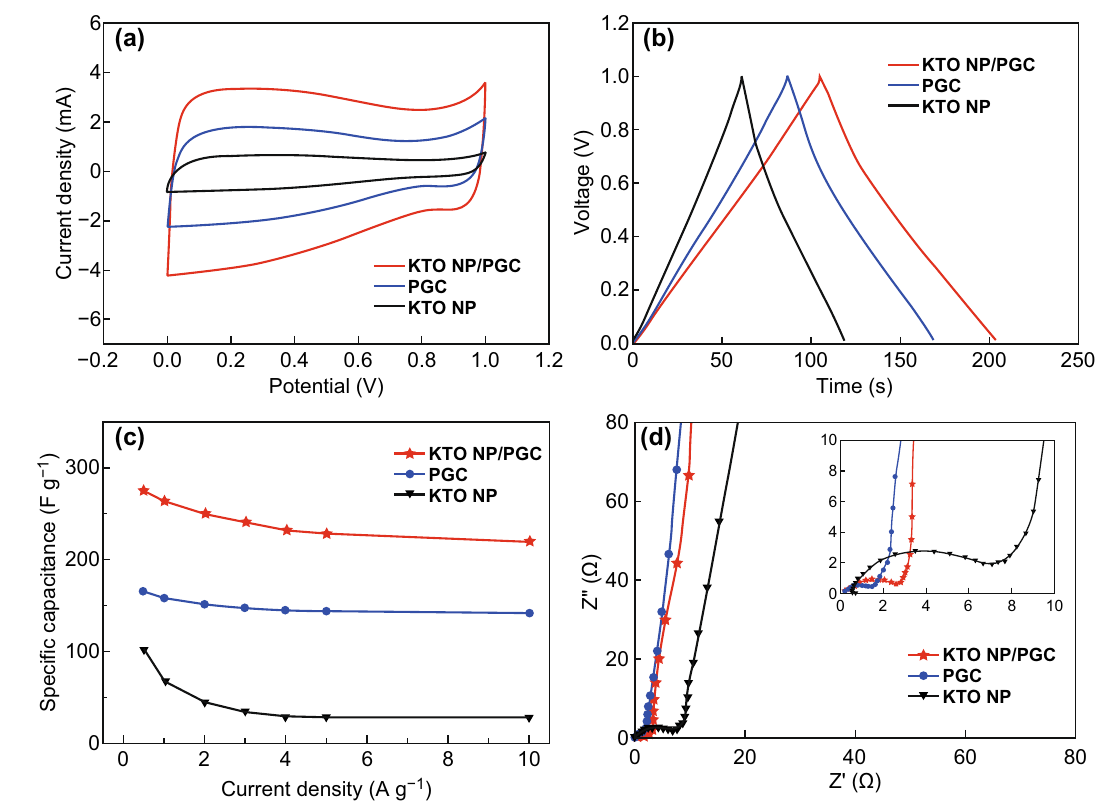
Fig. 7 a CV curves, b GCD curves, c specific capacitances, d EIS curves of the KTO NPs, PGC, and KTO NP/PGC composites measured using a symmetric two‑electrode system